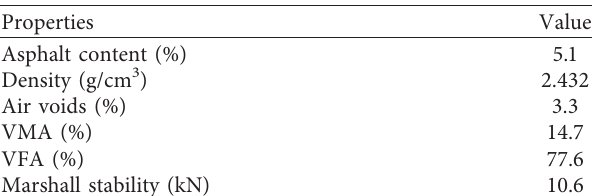
Figure 1: The structures of (a) flexible pavement and (b) semirigid pavement. Table 1: The Marshall properties of the AC-13 mixture.